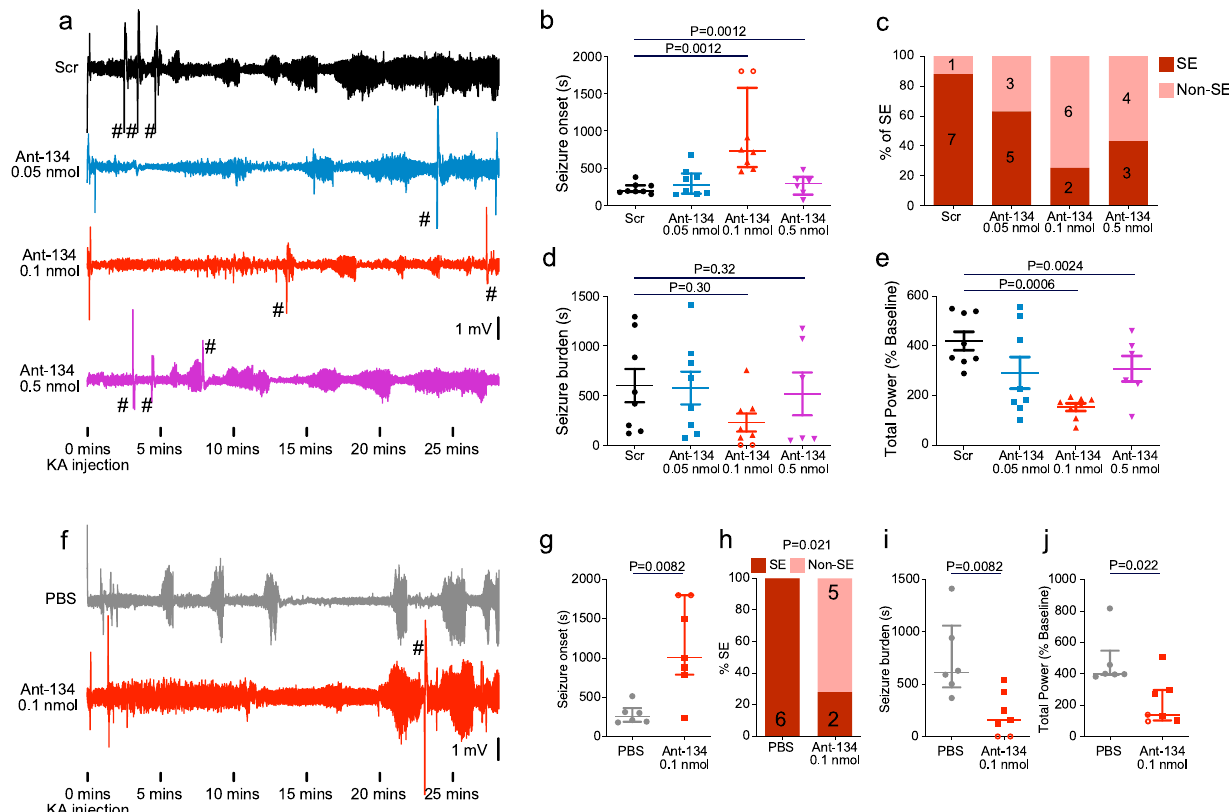
Figure 5. Protective effects of Ant-134 on SE severity in P21 mice. ( a ) Representative EEG traces from mice pre-treated with 0.05, 0.1 or 0.5 nmol Ant-134 in 2 µL PBS, or scramble control (Scr). Traces shown begin at the time of KA injection. ( b ) Dose-dependent effects of Ant-134 on seizure severity (N = 8 per group [Scr,0.05 nmol,0.1 nmol] or N = 5 [0.5 nmol]). 0.1 nmol Ant-134 increased time to seizure onset after KA injection. ( c ) There is a dose-dependent effect of Ant-134 on the percentage of mice experiencing SE following KA injection. There was no difference in seizure burden between groups and ( d ), however, there was a significant reduction in total EEG power in mice which received 0.1 nmol Ant-134 ( e ). ( f ) We performed a second set of experiments to validate the use of 0.1 nmol Ant-134 (N = 7, PBS N = 6). Representative traces start at the time of KA injection and show EEG recorded from mice pre-treated with 0.1 nmol Ant-134, or PBS control. ( g ) 0.1 nmol Ant-134 delayed seizure onset, reduced the percentage of mice experiencing full SE ( h ), reduced seizure burden, and reduced total EEG power ( j ). #—Artefacts caused by injections in other mice recorded simultaneously. Open circles represent mice which did not experience any seizure activity. Seizure onset was assigned a maximum value of 1800s for statistical